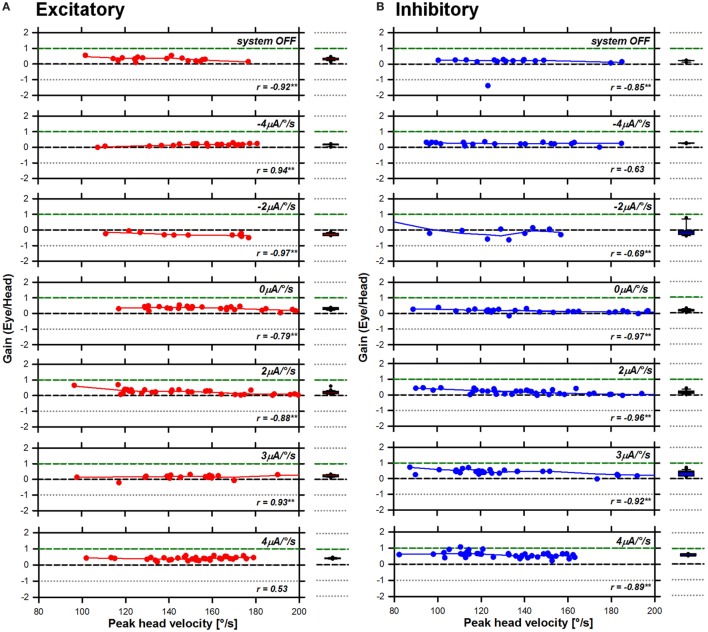
Angular vestibulo-ocular reflex (aVOR) gains recorded for S1 right anterior–left posterior in all experimental conditions. Panel (A) presents data gathered during excitatory head impulses (red plots), and panel (B) presents data gathered during inhibitory head impulses (blue plots). The line and scatter plots in the main panel present individual aVOR gains (scatter) as well as their corresponding smoothed (LOWESS, see Materials and Methods) values (lines) as a function of peak head angular velocity. The insets in the graph present the result of the statistical analysis for each condition (Pearson’s product-moment correlation coefficient; **p < 0.001—two-tailed). The box plots to the right present the median values, as well as the 25th–75th percentiles of the smoothed data pooled across head velocities. The error bars represent the 10th and 90th percentiles and the symbols present all outliers outside this range.